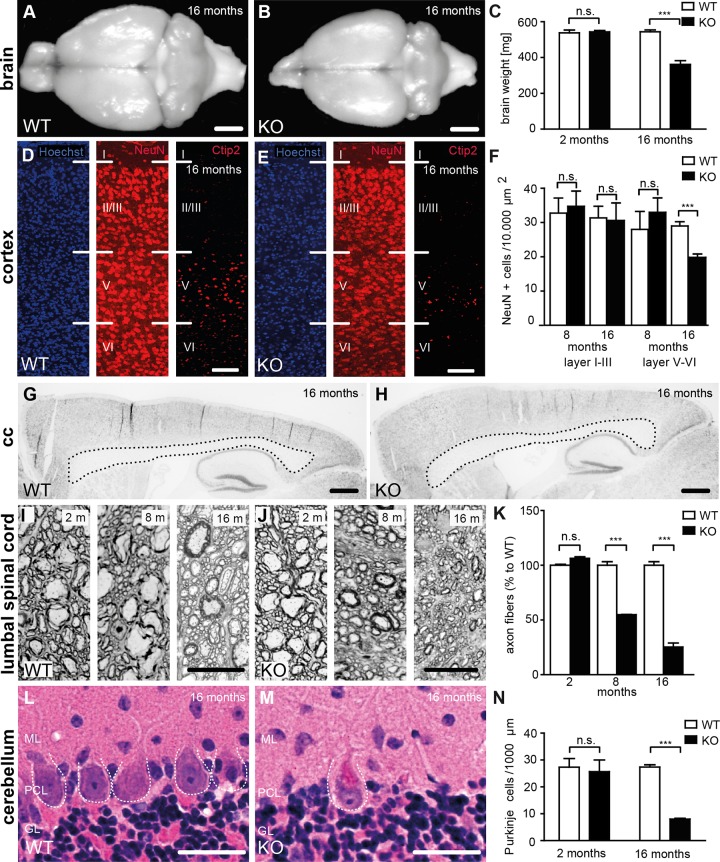
Loss of Spatacsin causes severe neuron loss in the motor cortex and the cerebellum.
(A-B) Brain size is reduced in 16-month-old KO compared to WT mice. Scale bars: 2 mm. (C) Progressive reduction of brain weight in KO mice (n = 3; Student’s t-test: *** indicates p<0.001). (D-F) Neuron loss in the motor cortex of 16-month-old KO mice. Hoechst-33258 (blue; nuclei), NeuN (red; neuronal marker), and Ctip2 (red; marker for layer V neurons) staining of the motor cortex at 16 months of age from WT (D) and KO (E) mice. Individual cortical layers are labeled (I–VI). Scale bars: 100 μm. Quantification of NeuN-positive cells reveals a depletion of neurons from layers V-VI but not layers I-III of the motor cortex at 16 months of age in the KO (n = 3; Student’s t-test: *** indicates p<0.001). (G, H) Nissl stainings of sagittal brain sections do not support a thinning of the corpus callosum of 16-month-old KO mice. Scale bars: 500 μm (I-K) Semithin sections of the lumbar corticospinal tract show a loss of large diameter axons in 8- and 16-month-old KO mice (n = 3; Student’s t-test: *** indicates p<0.001). Scale bars: 20 μm. (L-N) Purkinje-cell loss in aged KO (M) but not WT (L) mice. ML: Molecular layer; PCL: Purkinje cell layer; GL: granular layer. The somata of Purkinje cells is indicated by a dotted line. (N) Quantification of Purkinje cells in hematoxylin-eosin stained cerebellum sections indicates a severe loss of Purkinje cells in aged KO mice (n = 3; Student’s t-test: *** indicates p<0.001). Scale bars: 40 μm.